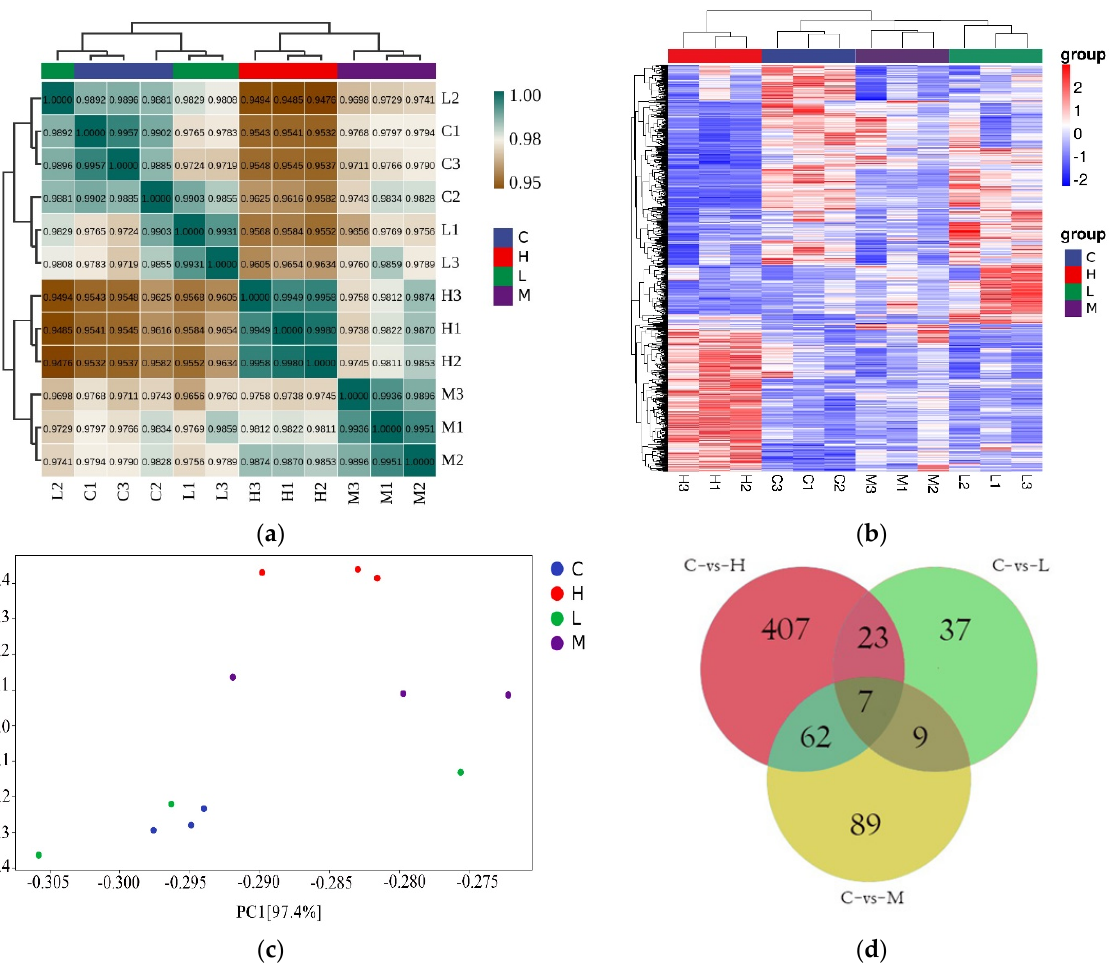
Figure 3. Transcriptomic profiling of D. magna following a 21 d exposure to pravastatin sodium (PRA): ( a ) Correlation analysis of patterns of gene expression level in control and three treatment groups; ( b ) A heatmap of centered and scaled FPKM values of DEGs in controls and three treatment groups; ( c ) Principal component analysis (PCA) of FPKM profiles in three treatment groups; ( d ) Venn diagram of the number of DEGs in three treatment groups. L, M and H represent the low, medium and high PRA treatment groups, respectively. Table 1. List of crucial biological pathways disrupted by PRA exposure ( p < 0.05).